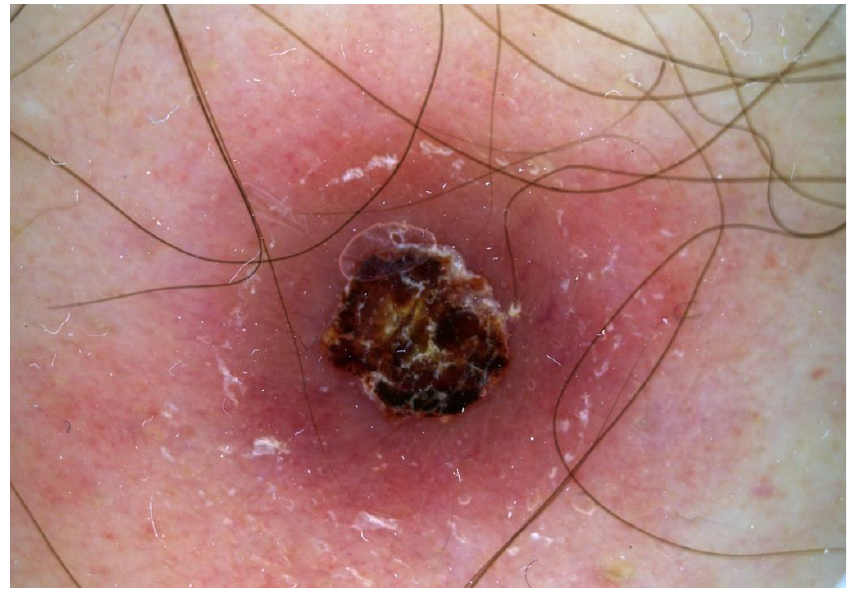
Figure 2. Dermoscopic image showing an erythematous, copper-colored, oval lesion with diffuse monomorphic dotted and glomerular vessels, central crust and circular scaling (Biett’s sign).